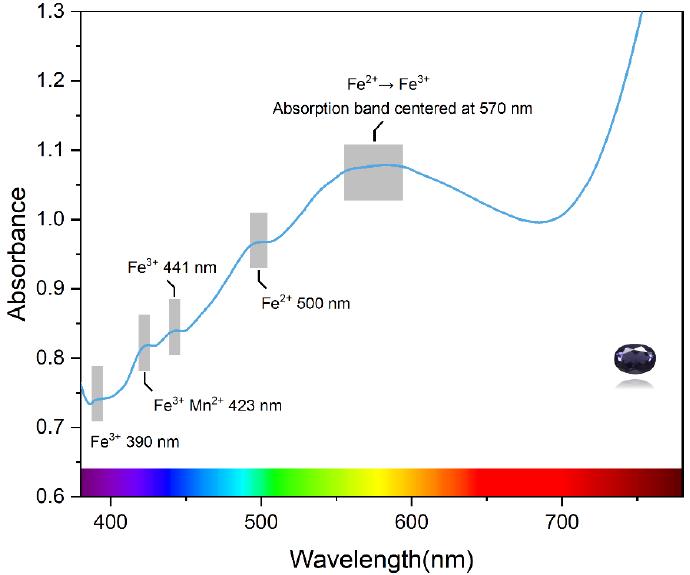
Figure 6. UV–vis spectroscopy of the iolite.